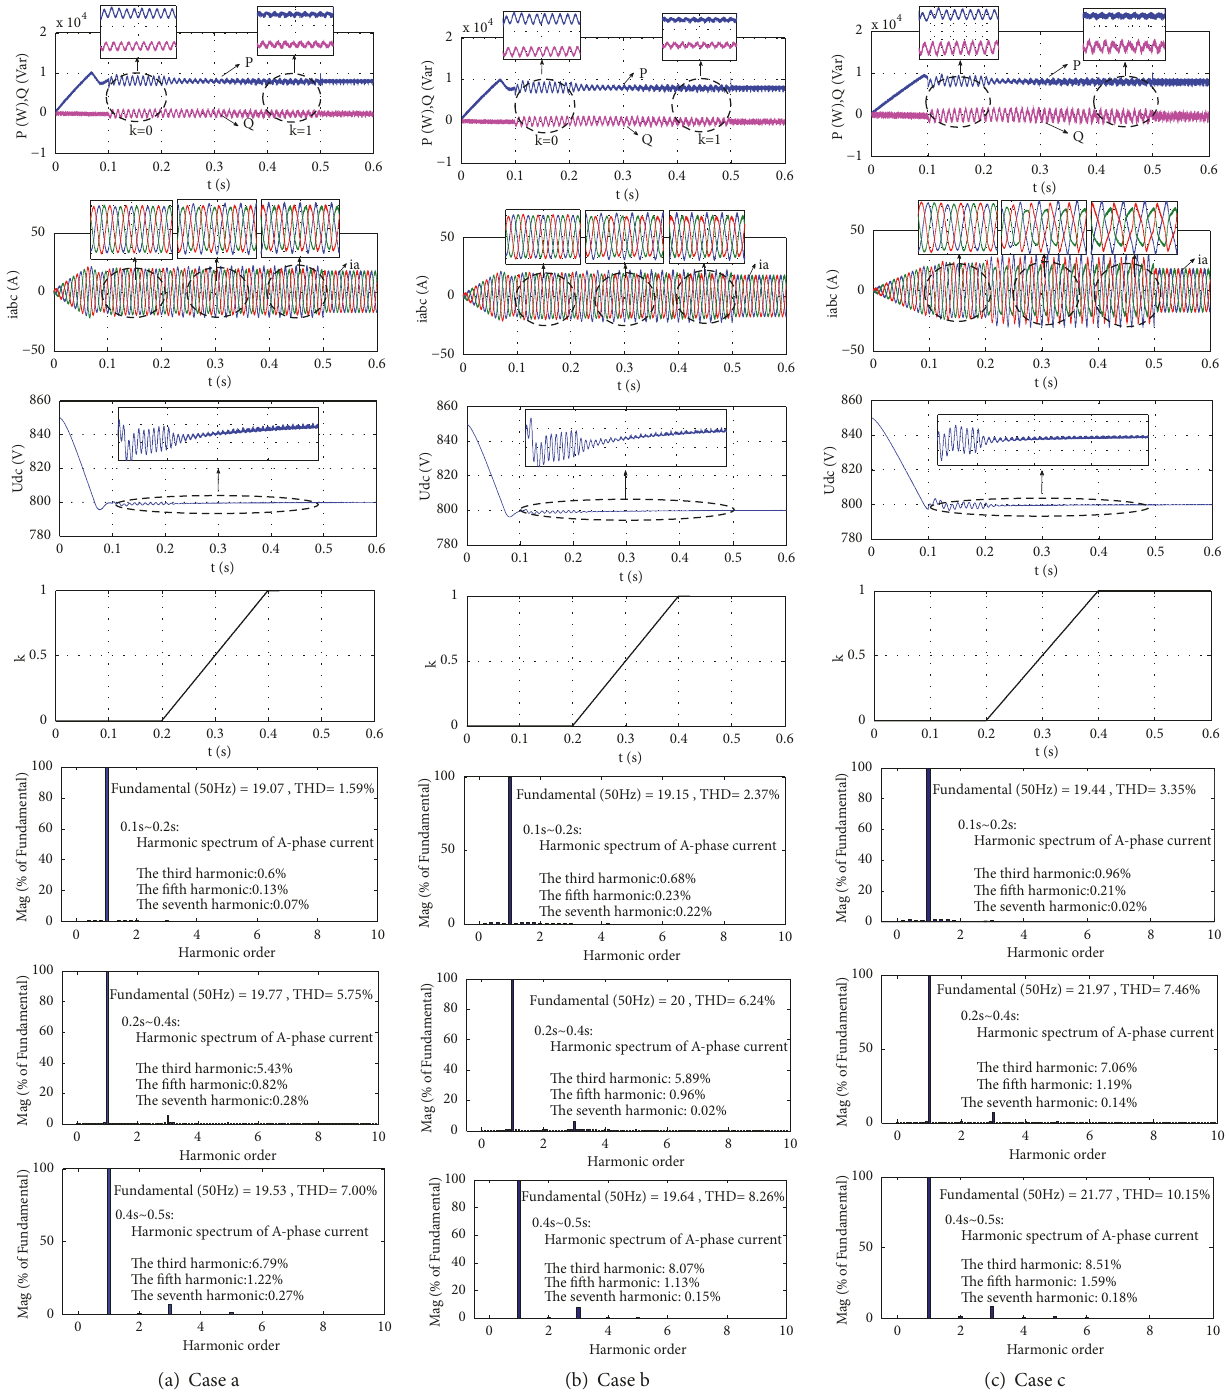
0.1s~0.2s: Harmonic spectrum of A-phase current The third harmonic:0.6% The fifth harmonic:0.13% The seventh harmonic:0.07% 0.2s~0.4s: Harmonic spectrum of A-phase current The third harmonic:5.43% The fifth harmonic:0.82% The seventh harmonic:0.28% Harmonic spectrum of A-phase current The third harmonic:6.79% The fifth harmonic:1.22% The seventh harmonic:0.27% Figure 15: Simulation results of proposed control strategy in different